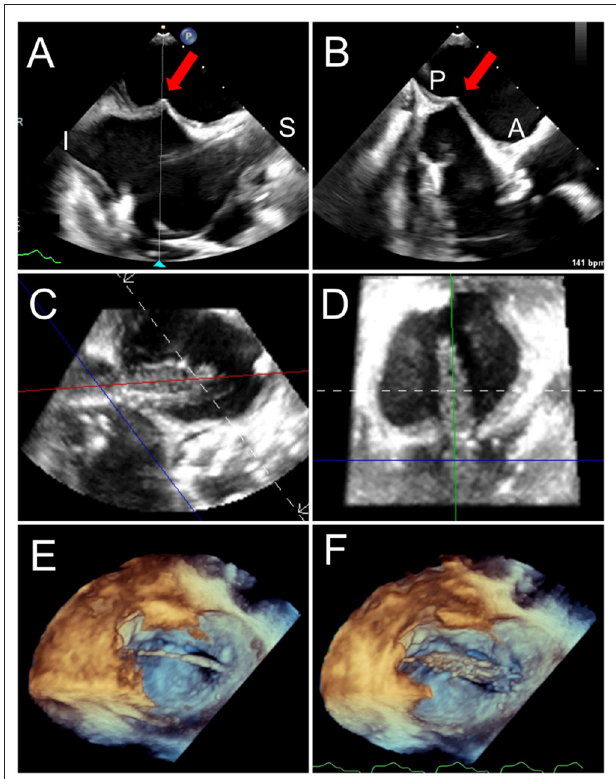
FIGURE 6 | Trans-septal puncture and septostomy for TMVR. A transseptal needle is seen tenting the interatrial septum (red arrows), best assessed utilizing biplane TEE imaging in the bi-caval (superior-inferior, A ) and short-axis (anterior-posterior, B ) views to confirm positioning in the inferior and posterior aspect of the fossa ovalis. After a successful transseptal puncture, a balloon is advanced over a stiff wire, and proper positioning across the septum can be verified utilizing live 3D MPR (C,D) . (E) The balloon is visualized in a 3D zoom volume-rendered image from the left atrial perspective. (F) The balloon is inflated for atrial septostomy in order to later accommodate the large crimped TMVR device. Supplementary Video 1 illustrates balloon inflation for atrial septostomy, as seen from the left